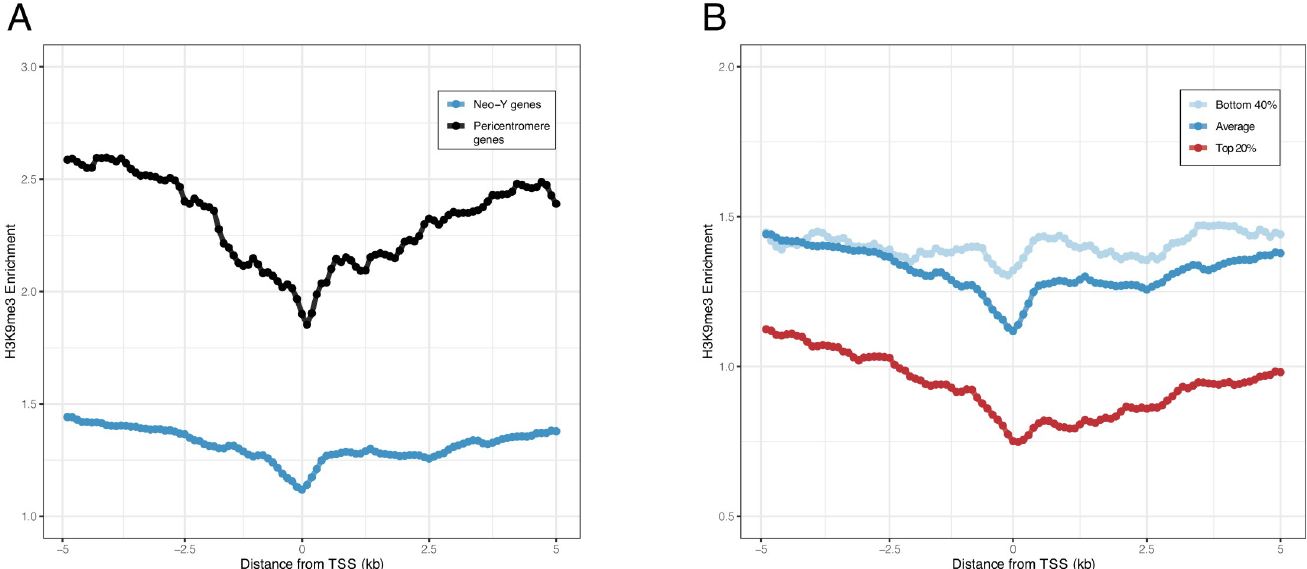
Fig 4. Heterochromatin enrichment at transcription start sites (TSS) on the neo-Y and the pericentromeres. A. The average young male H3K9me3 ChIP enrichment profile +/- 5kb of TSS in 100bp resolution grouped by gene location (neo-Y or pericentromere). B. The average young male enrichment profile at TSS neo-Y genes grouped and plotted by expression level. The resolution is also